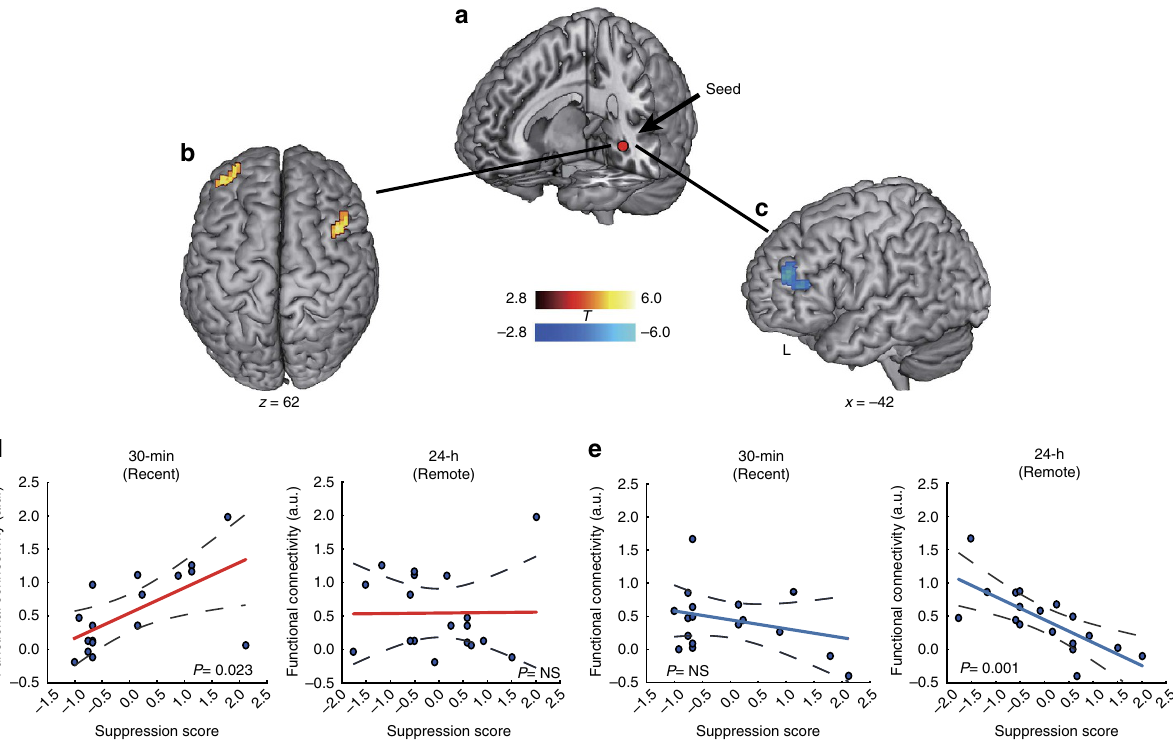
Figure 4 | Distinct hippocampal-prefrontal functional pathways after consolidation. ( a ) The left hippocampal seed (MNI, peak at (cid:2) 33, (cid:2) 33 and (cid:2) 6) used in gPPI analysis of task-based functional connectivity during memory suppression. ( b , d ) Increased hippocampal functional connectivity with the left and right DLPFC was positively associated with more effective suppression for newly acquired memories (cluster in hot), but not after overnight consolidation. ( c , e ) Attenuated hippocampal functional connectivity with the left DLPFC was predictive of more effective suppression of overnight consolidated memories (cluster in blue), but not for newly acquired ones. Dotted lines indicate 95% confidence intervals and solid line indicates the best linear fit. MNI, Montreal Neurological Institute coordinate system.